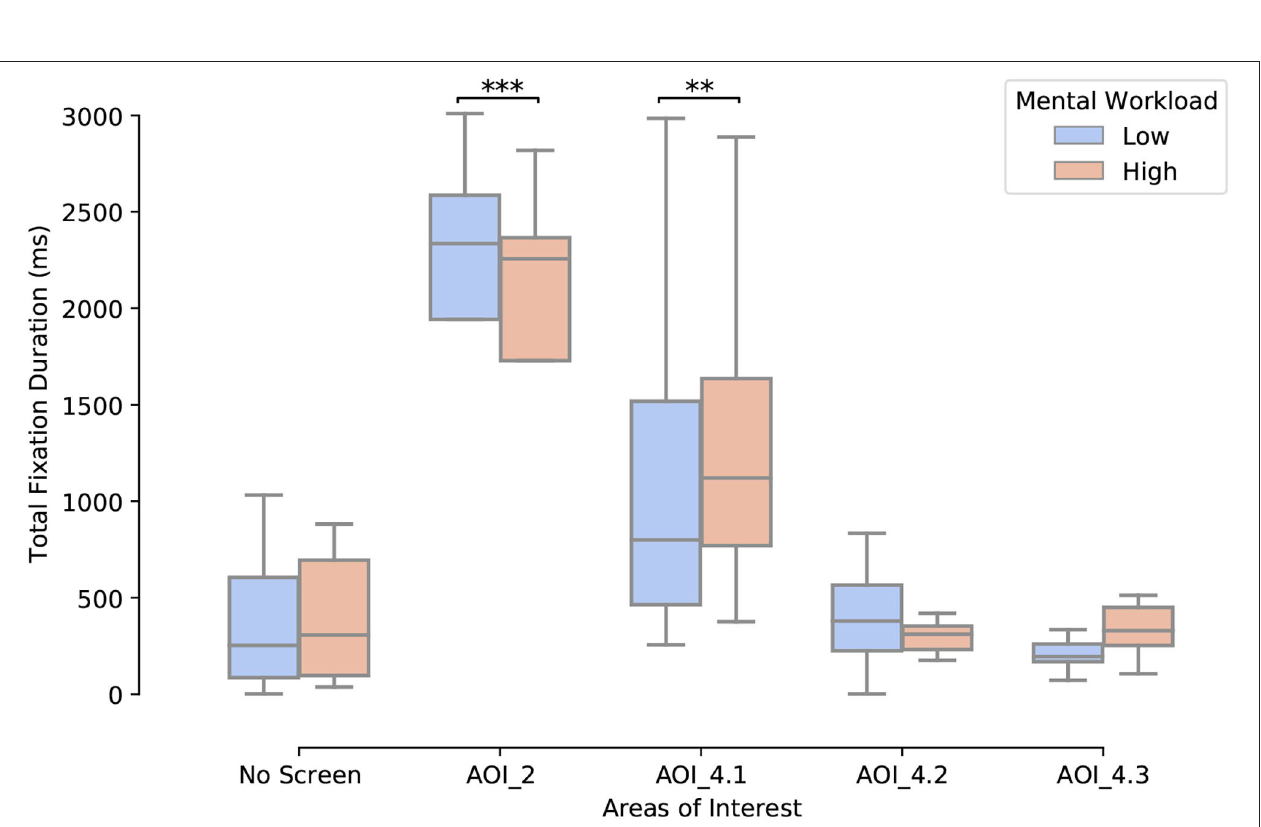
FIGURE 9 | Impact of the mental workload condition on the total duration of fixations per AOI (** p < 0.01, *** p < 0.001).